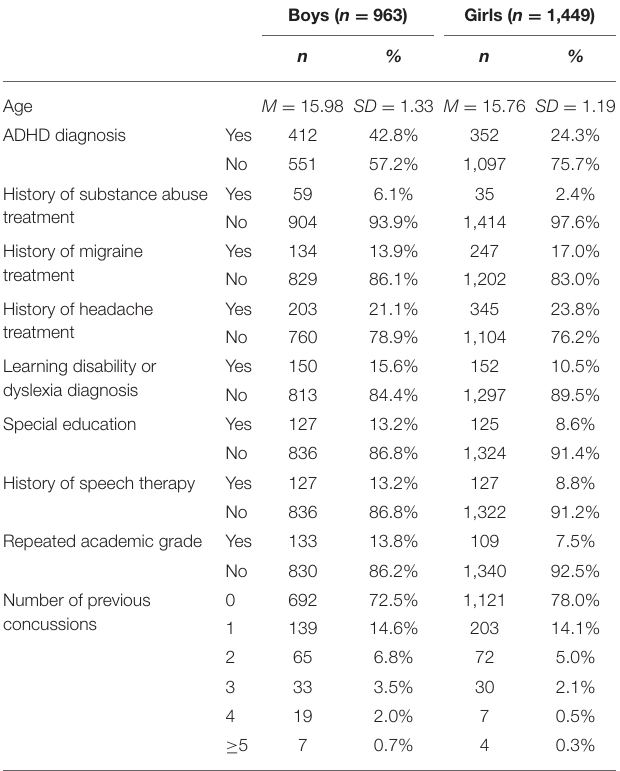
TABLE 1 | Characteristics of the student athletes with a history of mental health treatment.